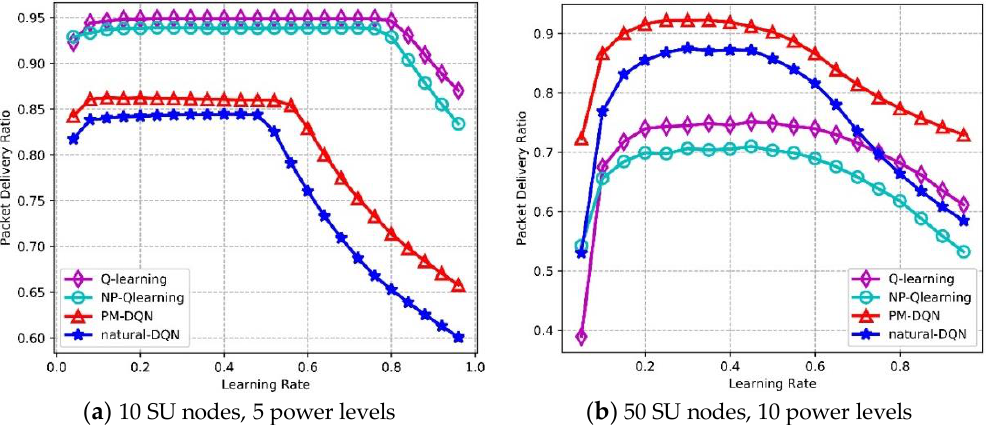
Figure 13. Packet delivery ratio vs. learning rate.